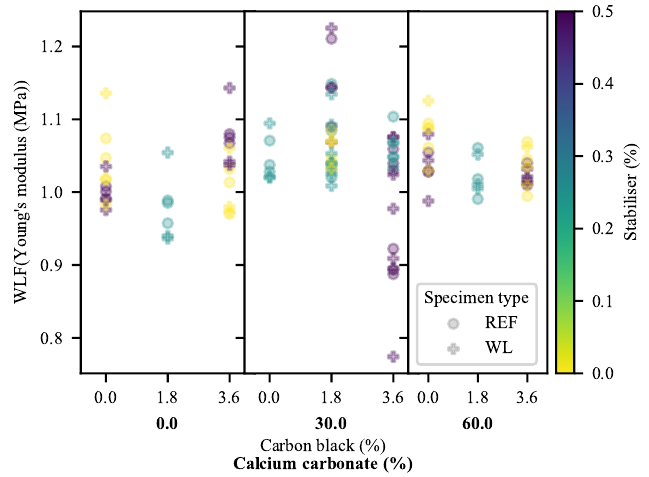
Figure 5. WLF(YM) as a function of the loadings of calcium carbonate, carbon black and the stabiliser package. Of particular interest, here, is the trend for the factors to be slightly above 1, virtually regardless of